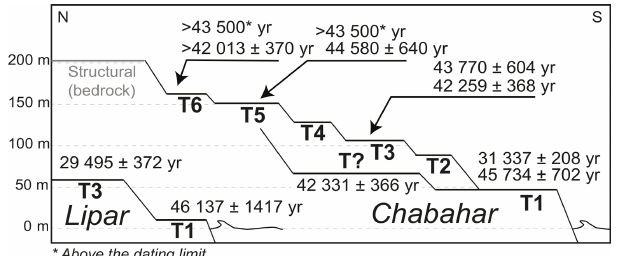
Figure 8. 14 C dating on Chabahar–Ramin and Lipar terraces. There is no morpho-stratigraphic relationship between the terrace ages and altitude if we consider the 14 C ages to be